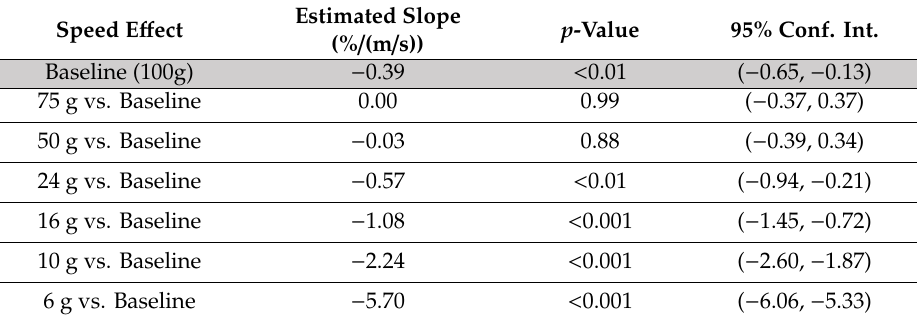
Table A1. E ff ect of speed on the cumulative distance versus accelerometer range. First (shaded) row reports the estimated slope of the cumulative distance versus mean speed using the baseline sensor (100 g range accelerometer). Remaining (unshaded) rows report estimated di ff erences in this slope for IMUs with indicated acceleration ranges compared to the baseline IMU (i.e., the increased error sensitivity to speed with the indicated reductions in acceleration range relative to the baseline range).